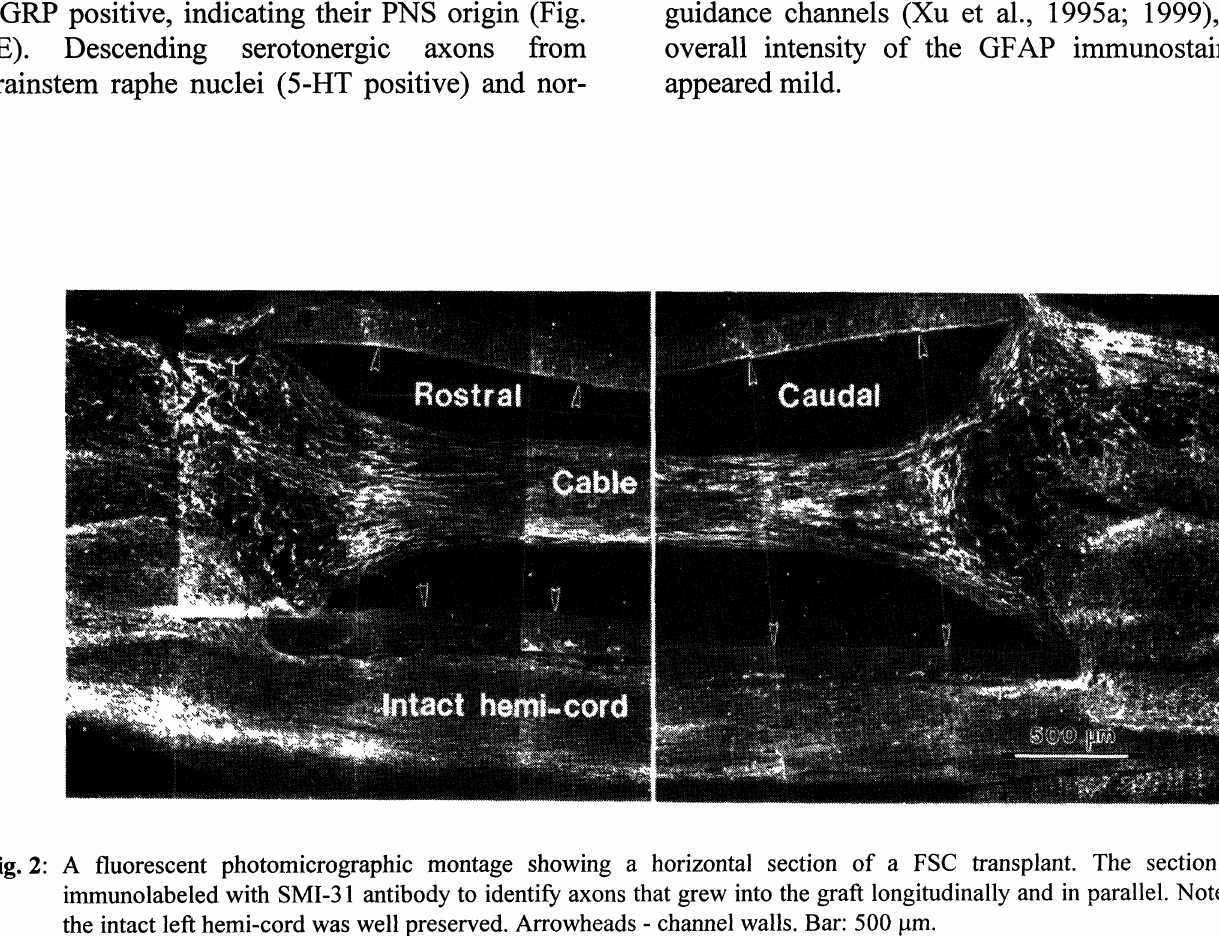
Fig. 2" A fluorescent photomicrographic montage showing a horizontal section of a FSC transplant. The section was immunolabeled with SMI-31 antibody to identify axons that grew into the graft longitudinally and in parallel. Note that the intact left hemi-cord was well preserved. Arrowheads channel walls. Bar: